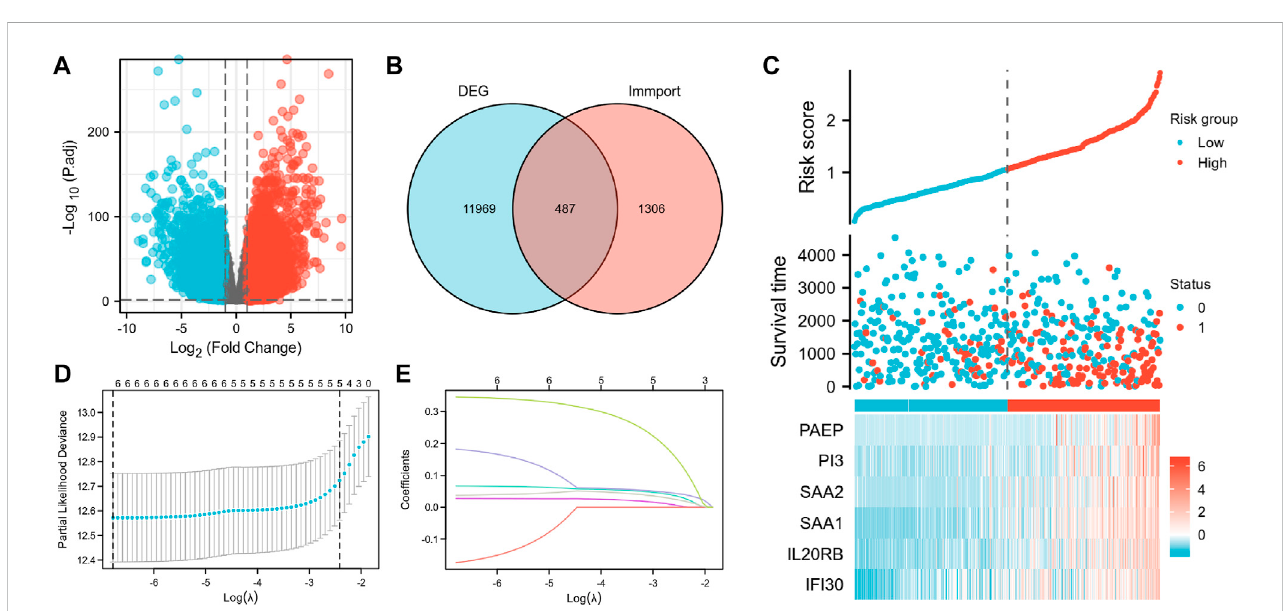
FIGURE 2 Construction of theIRSS. (A) Volcano plotof differentially expressedgenes. (B) Intersection Venn diagram of DEGs and immunity-relatedgenes. (C) Risk scores, survival status, and heat maps of six immunity-related genes in KIRC patients. (D) Ten-fold cross-validation of the LASSO model-related